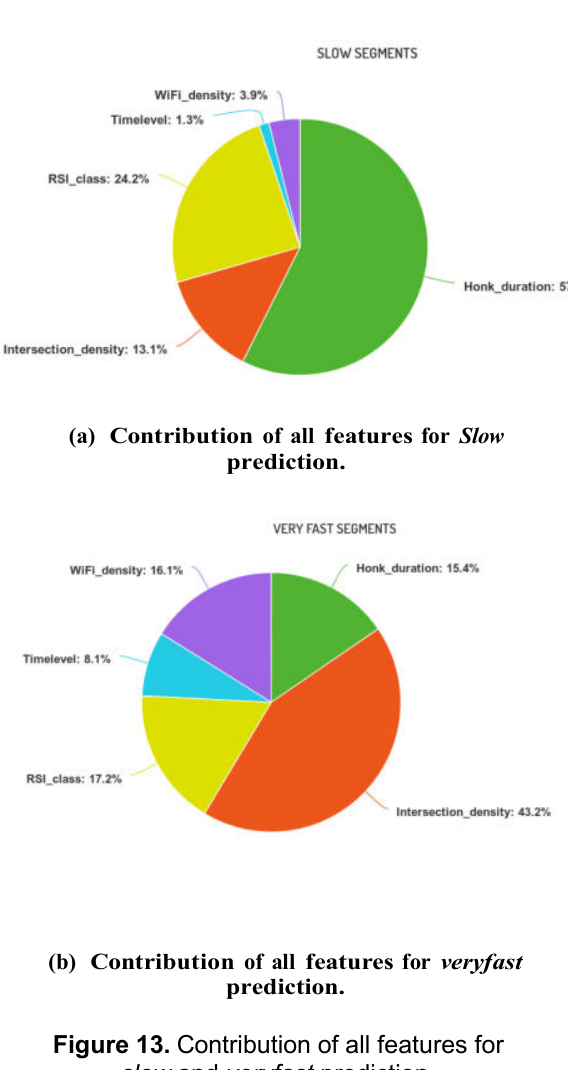
Figure 13. Contribution of all features for slow and veryfast